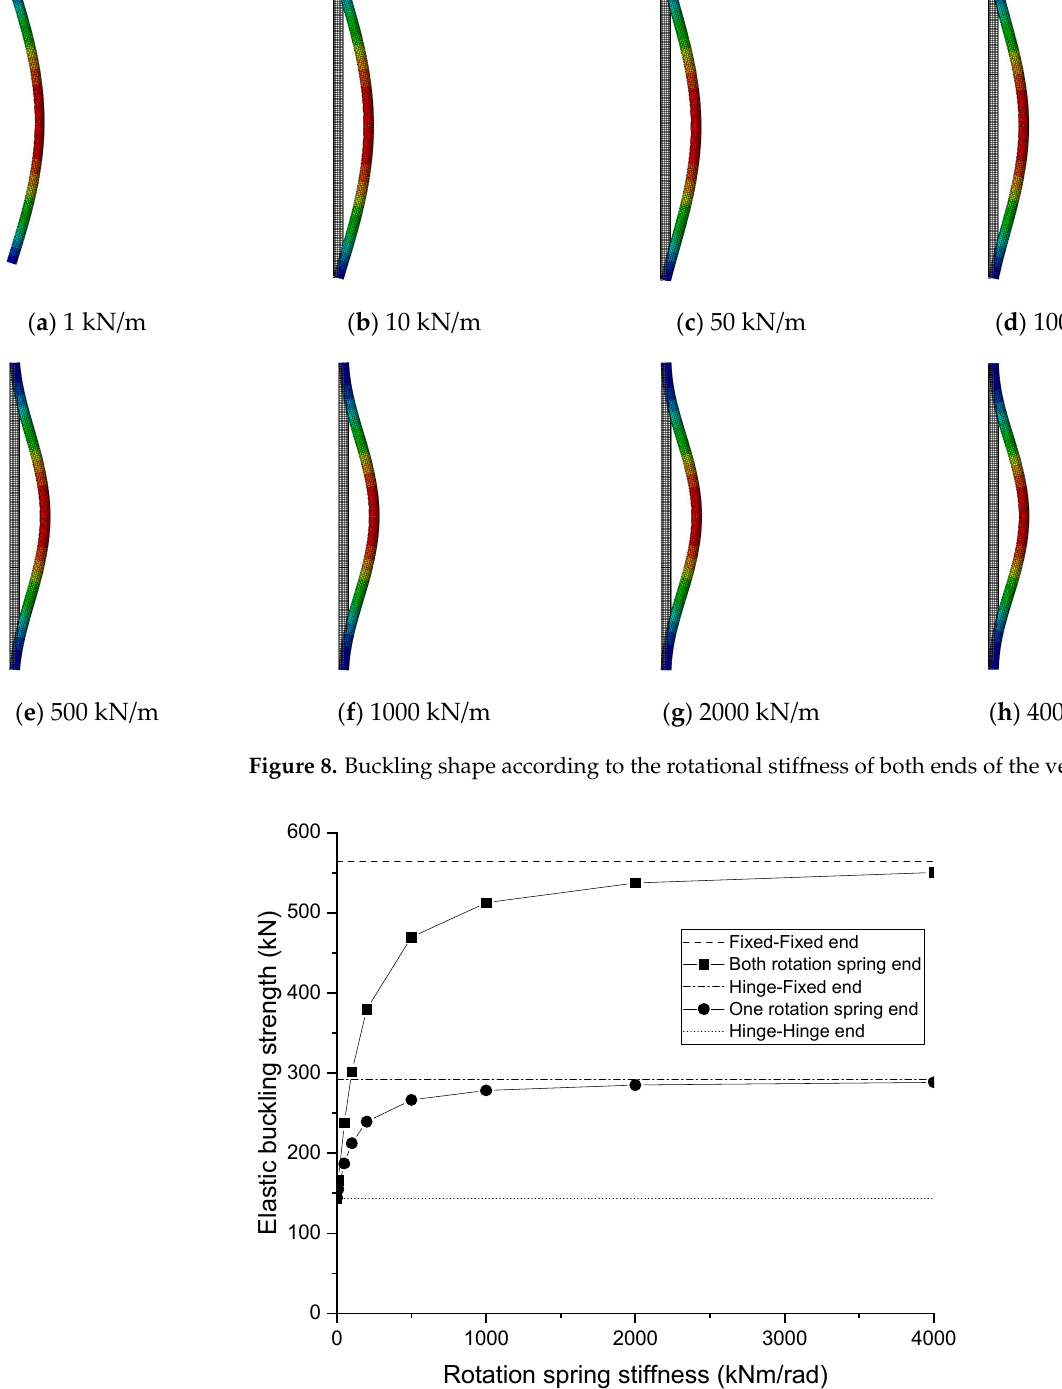
Figure 9. Buckling strength curve according to rotational stiffness.